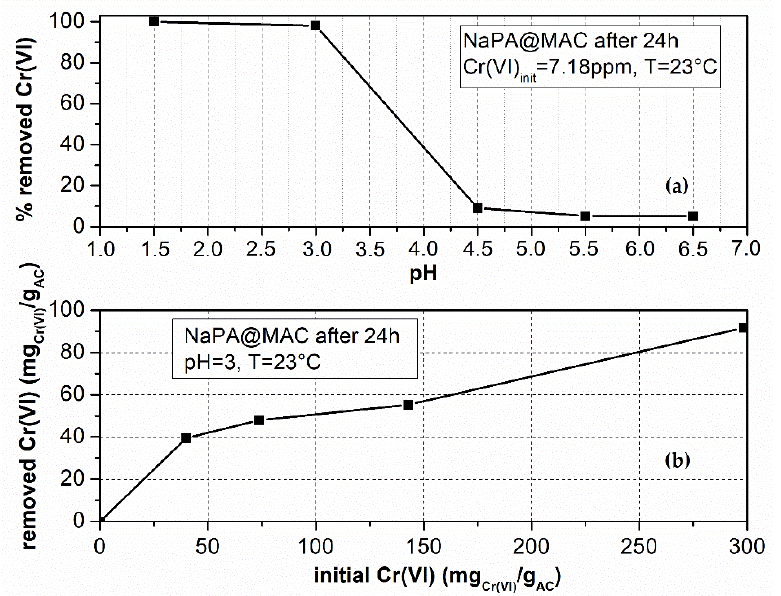
Figure 8. ( a ) Effect of pH on maximum removed Cr(VI) for the NaPA@MAC material. ( b ) Effect of initial Cr(VI) concentration on maximum removed Cr(VI) amount after 24 h for pH = 3 and T = 23 °C.